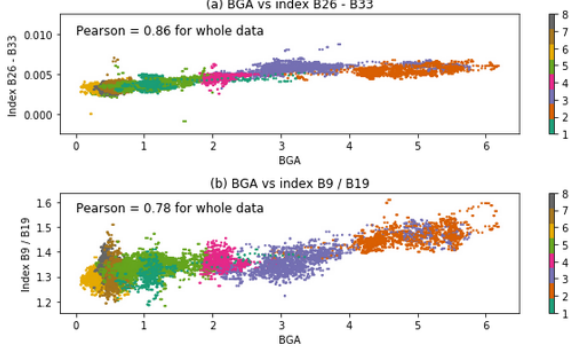
Figure 15. Scatter figures of the parameter BGA with the indices B26 − B33 and B9 / B19 (whose mutual correlation is 0.56) The scatter plots of figure 15 have been color coded by